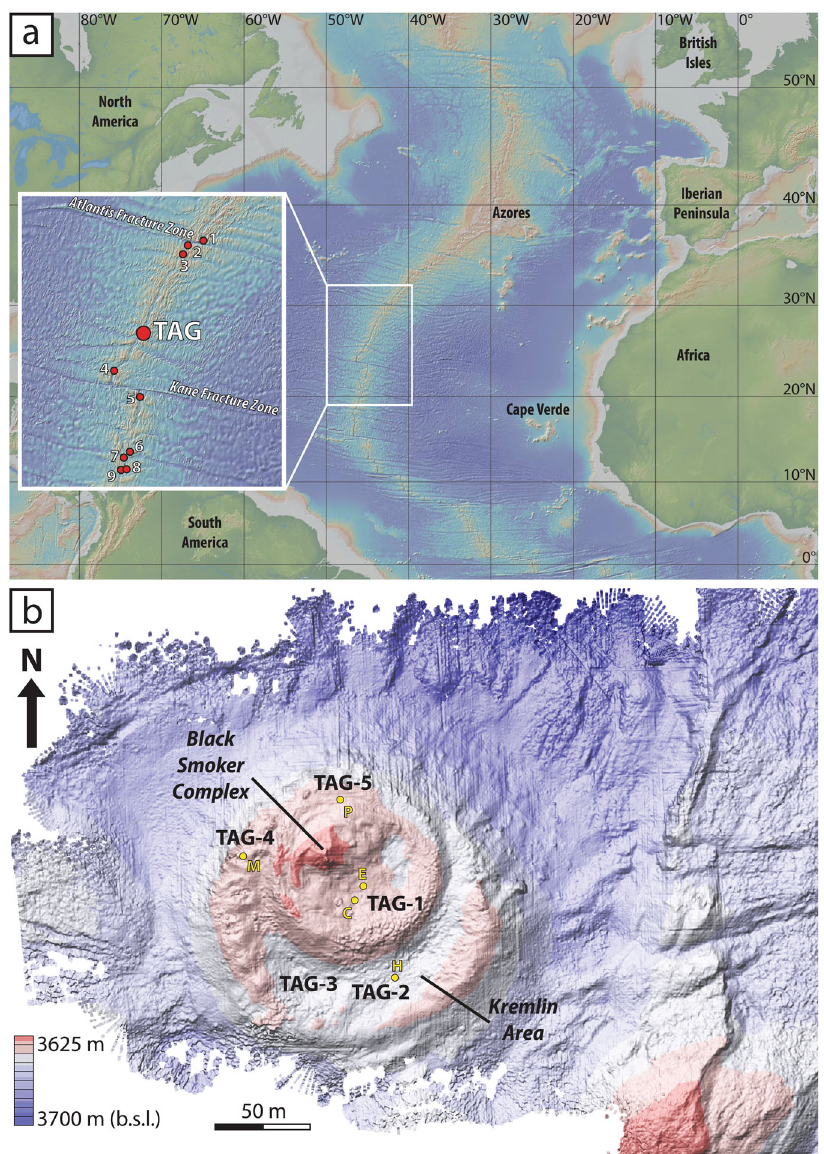
Fig. 1 Bathymetric maps with sampling locations. a Location of TAG and other hydrothermal vent fi elds and sul fi de deposits (red symbols) along the TAG segment, north-central Mid-Atlantic Ridge: 1 — Lost City; 2 — MAR 30°N; 3 — Broken Spur; 4 — MAR 24°30 ’ N; 5 — Snakepit; 6 — Surprise; 7 — Puy des Folles; 8 — Zenith-Victory; 9 — Yubileinoe. Map modi fi ed from ref. 68 and ref. 69 and retrieved via GeoMapApp (http://www.geomapapp.org). b Detailed map of the TAG mound showing the collar locations of the ODP Leg 158 drill cores used in this study (957C, 957E, 957H, 957M, and 957P). Map modi fi ed from ref. 70 and retrieved via